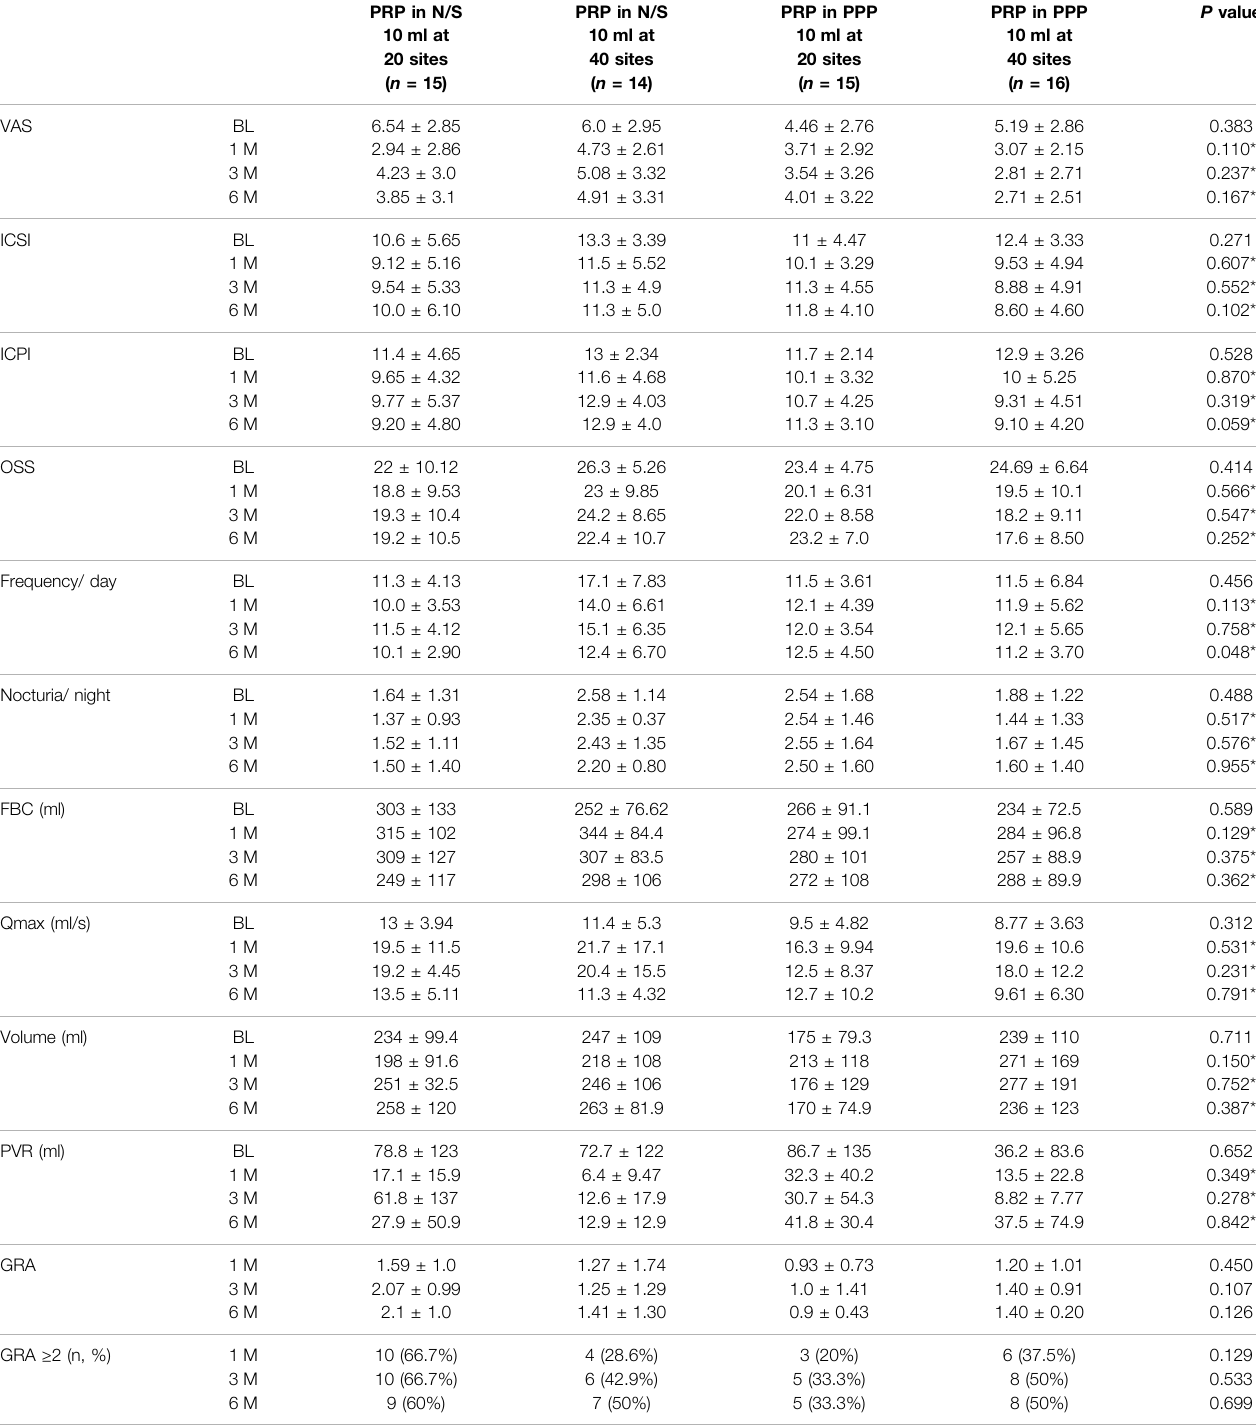
TABLE 2 | Comparison of the treatment results among IC/BPS patients treated with different PRP preparation and injection